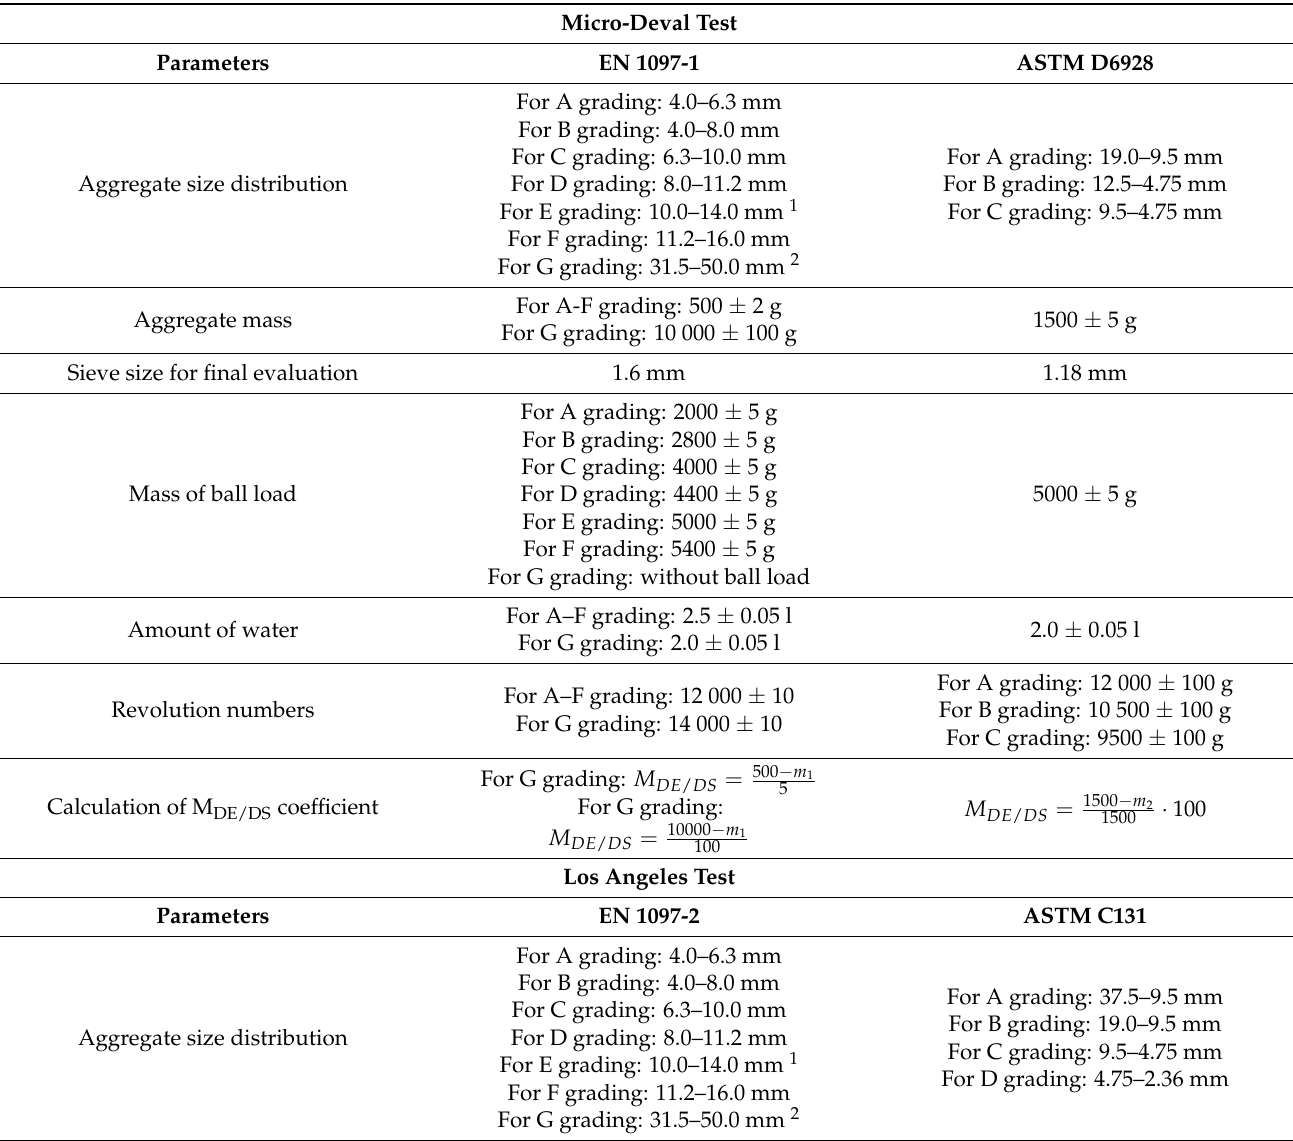
Table 2. Comparison of test parameters (own study based on Gökalp and Uz [4], Gökalp et al. [29], Wu et al. [30]).